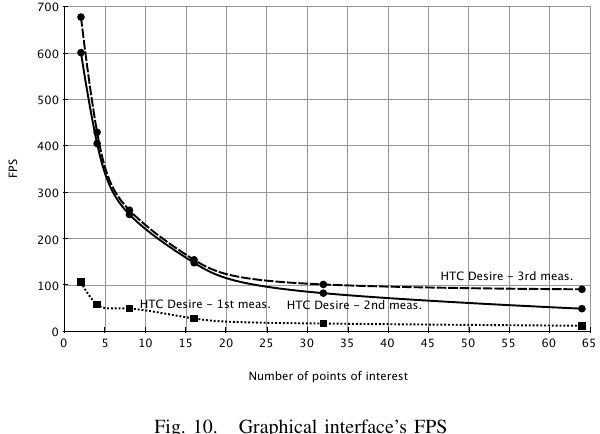
Fig. 10. Graphical interface’s